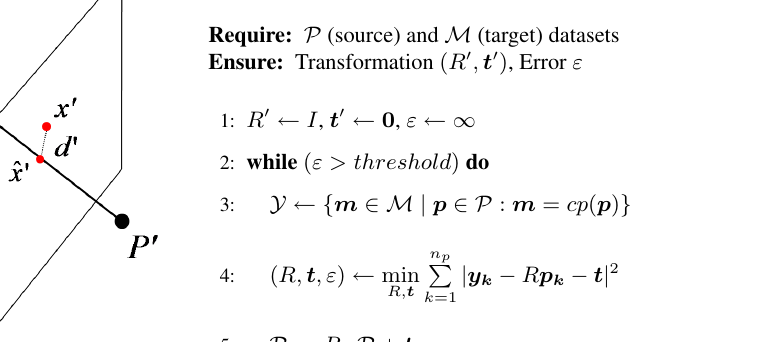
Figure 1: The reprojection error